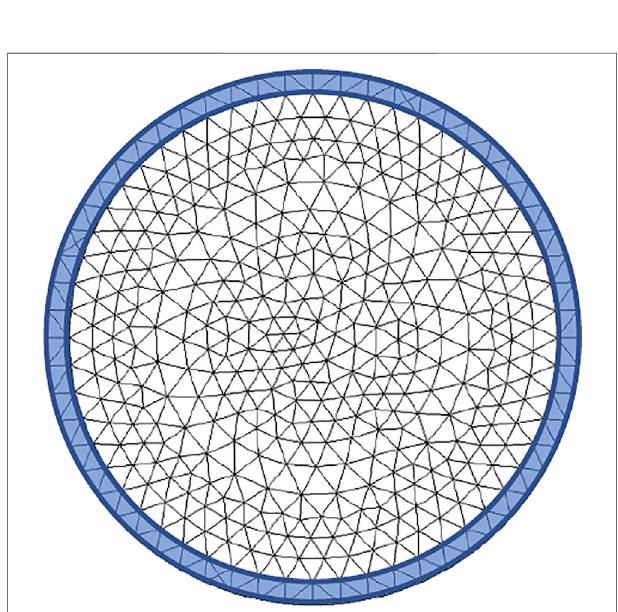
FIGURE 4 | FEM mesh in the two-layer spherical